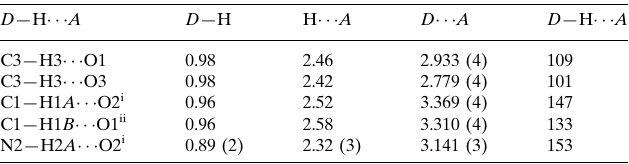
Hydrogen-bond geometry (A˚ , (cid:1)